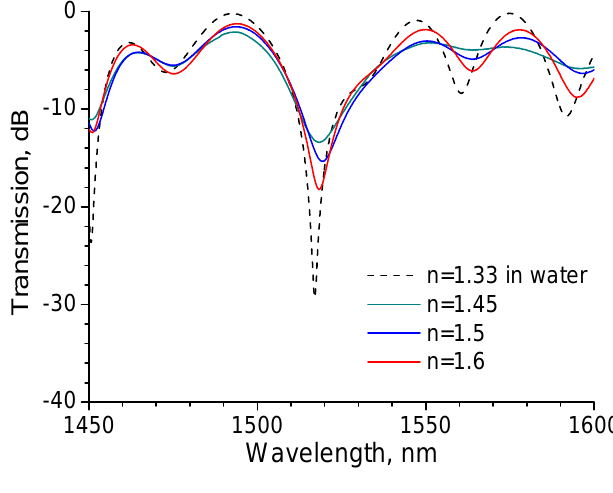
Figure 3. Transmission spectra of a 30-mm-long straight LPG surrounded by a medium having a refractive index that is higher than that of